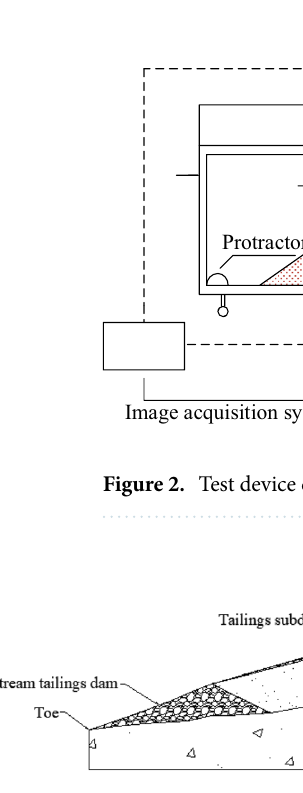
Figure 3. Test models of three working conditions.